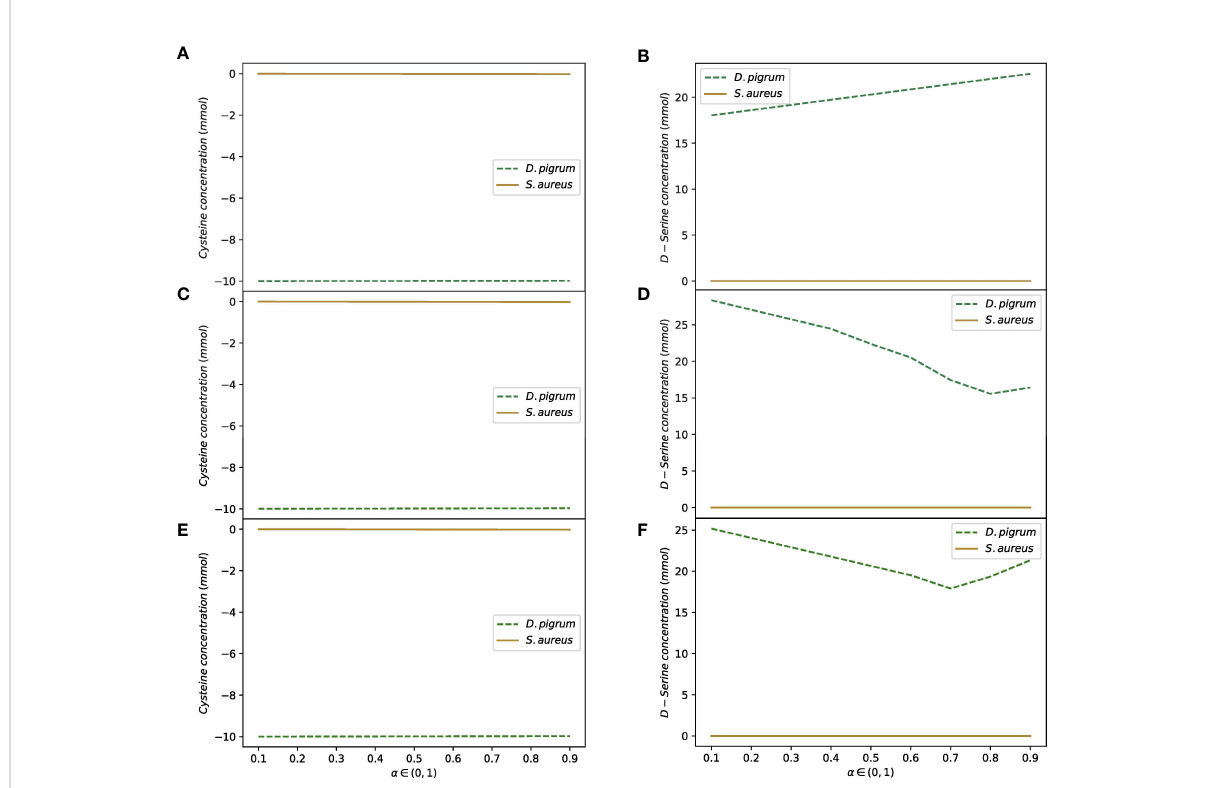
FIGURE 4 D-serine is released by D. pigrum as the compartmentalized community model with shuttle reactions is used. The convex objective function is implemented. The medium is de fi ned for SNM3, exchange, and COMPM. The release of D-serine does not depend on all different media used. This is released in high amounts in all different settings of the community as a in the objective function is changed in the range of (0, 1). Cysteine is also taken up by D. pigrum. S. aureus does not depend on the amount of uptake of cysteine or released D-serine. (A) Shows how cysteine is taken up by D. pigrum while S. aureus is not in fl uenced by cysteine while (B) Shows how D-serine is released by D. pigrum as the de fi ned medium is SNM3. (C, D) Denote the uptake of cysteine by D. pigrum while S. aureus is not in fl uenced by cysteine and secreting D- serine by D. pigrum as exchange medium is de fi ned. (E, F) Indicate the uptake of cysteine by D. pigrum and no in fl uence of cysteine, as well as the release of D-serine by D. pigrum while the medium is de fi ned as